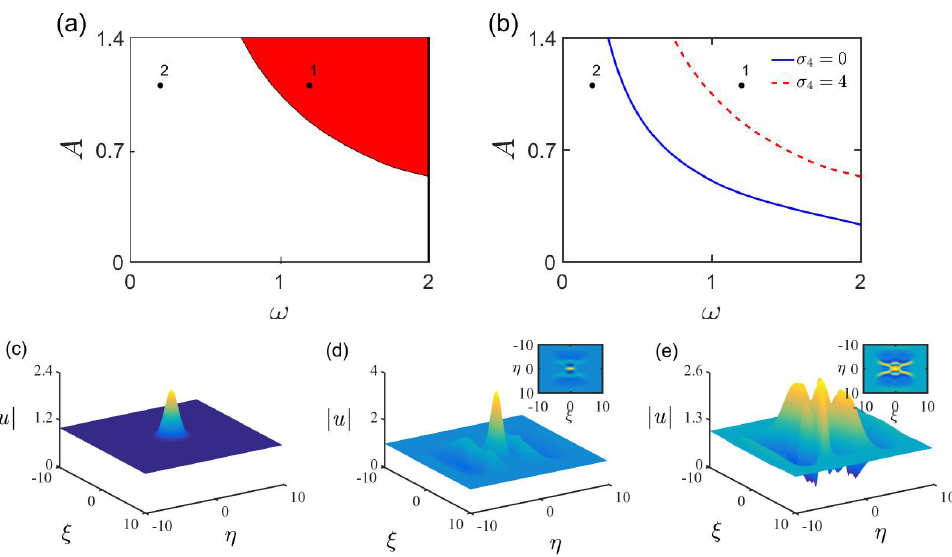
Figure 5. (Color online) ( a ) The existence regions of nonlinear modes. The red region denotes rogue waves. ( b ) The phase-transition curves of rogue waves for Equation (11) with σ 4 = 0 (blue solid line) and 4.0 (red dotted line). ( c – e ) The profiles of nonlinear modes when s = 0, 1.08, and 1.60, respectively. Here, ω =